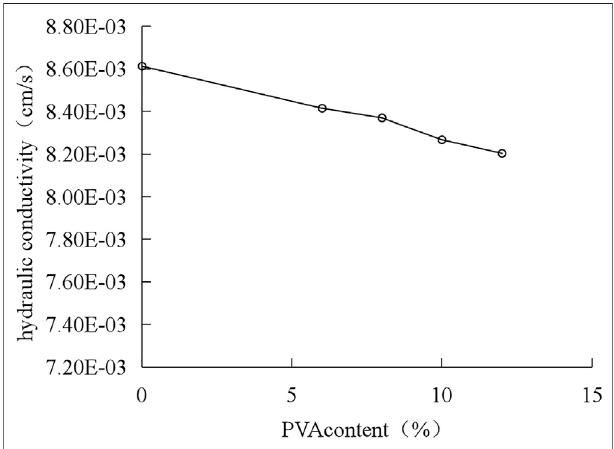
FIGURE 7 | Relationship between permeability coef fi cient and PVA gel dosage.